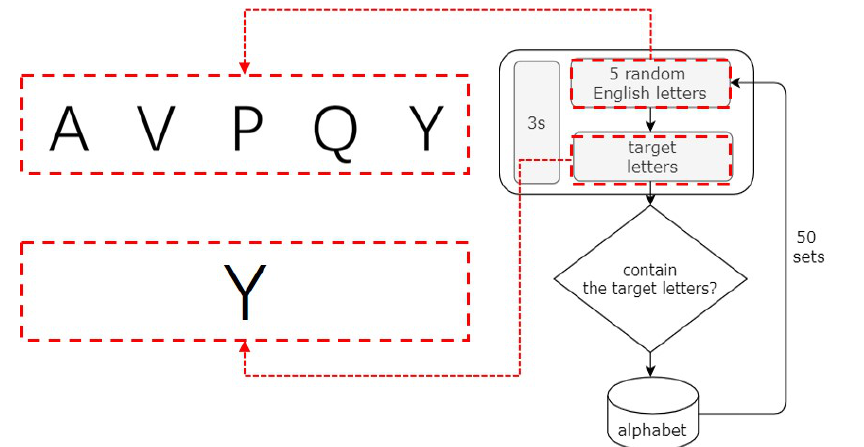
Figure 2. Premise of letter discrimination